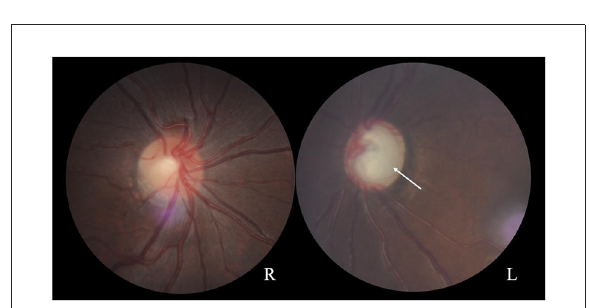
FIGURE2 Fundus photographs showing a normal optic disc in the right eye and a pale optic disc with a clear border in the left eye (arrow). The cup-to-disc ratio is 0.3 for the right eye and 0.9 for the left eye.